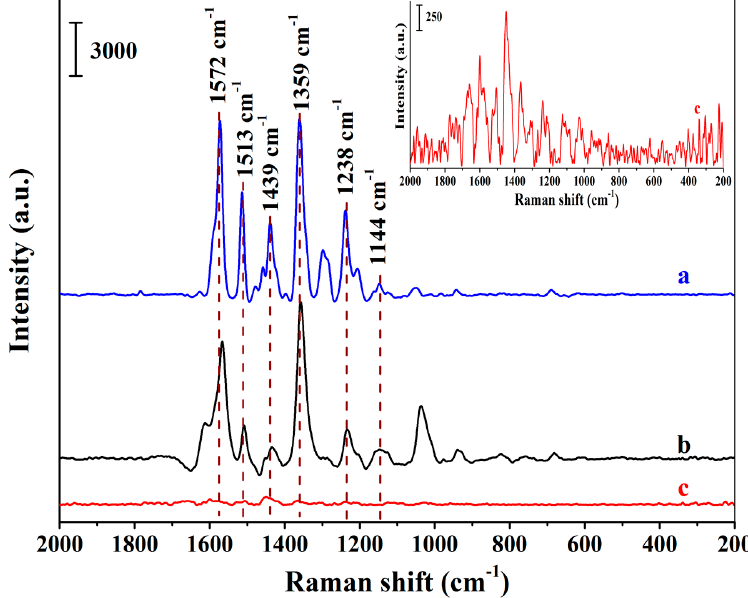
Figure 4. Surface-enhanced Raman spectroscopy ( SERS) spectra of New Red solid powders ( a ), MIHs absorbing 8.18 × 10 − 5 M of New Red ( b ), and NIHs absorbing 8.18 × 10 − 5 M of New Red ( c ); (Inset: The enlarged spectrum of c).